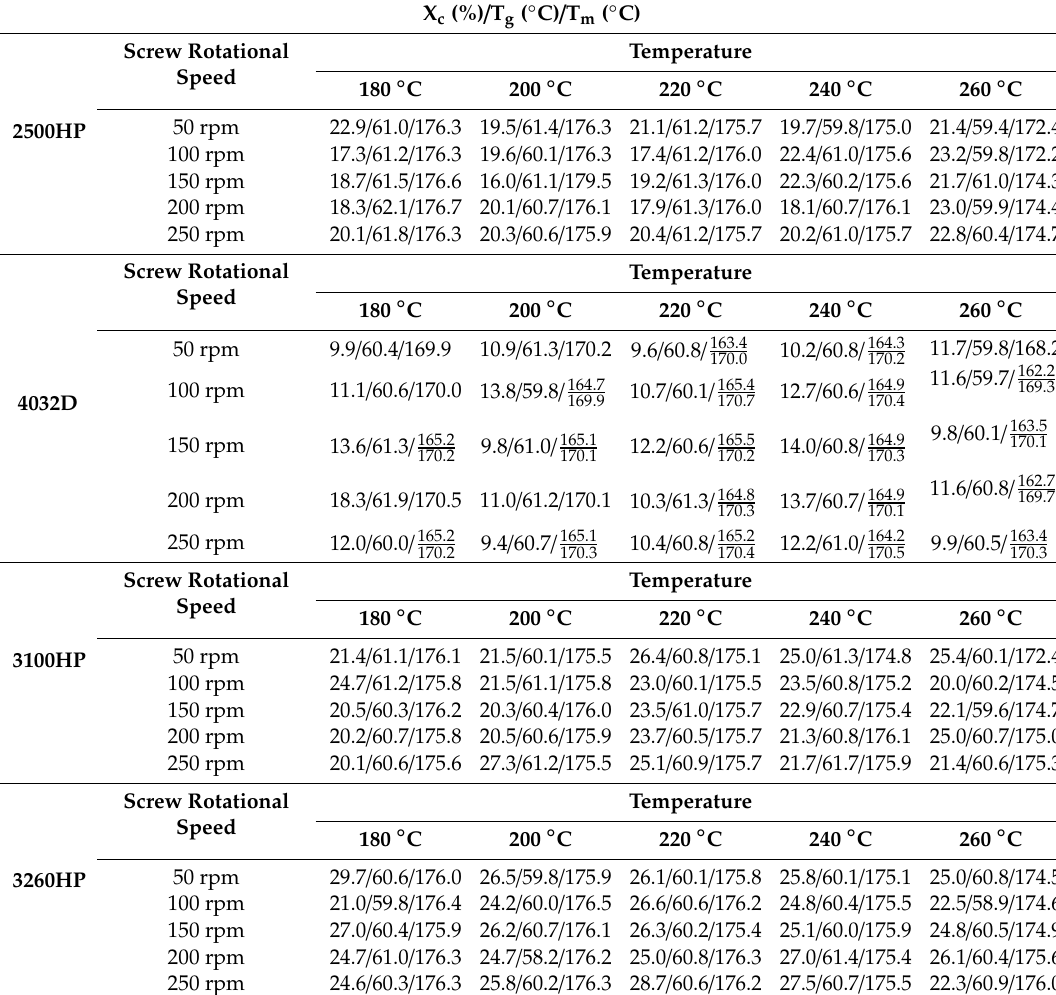
Table 5. Thermal parameters obtained from di ff erential scanning calorimetry (DSC)